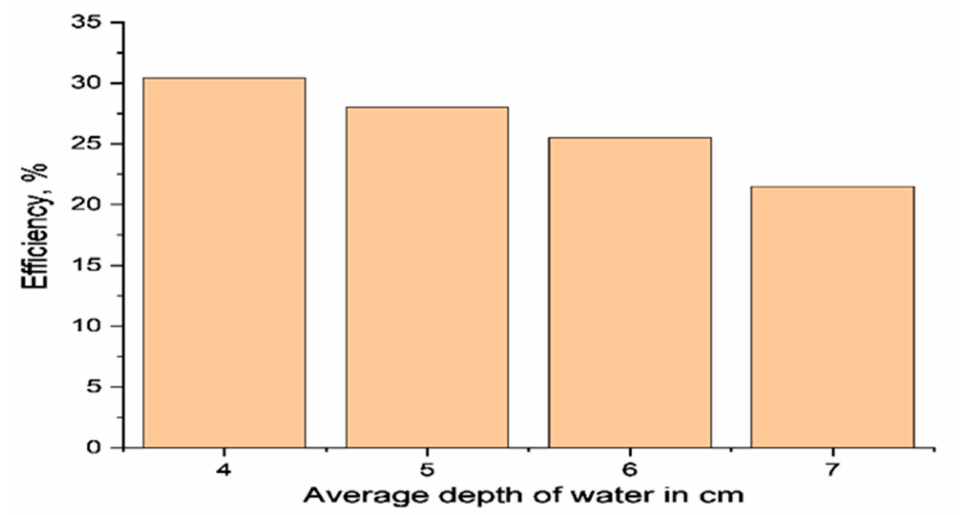
Figure 6. Daily efficiency with basin water depth.